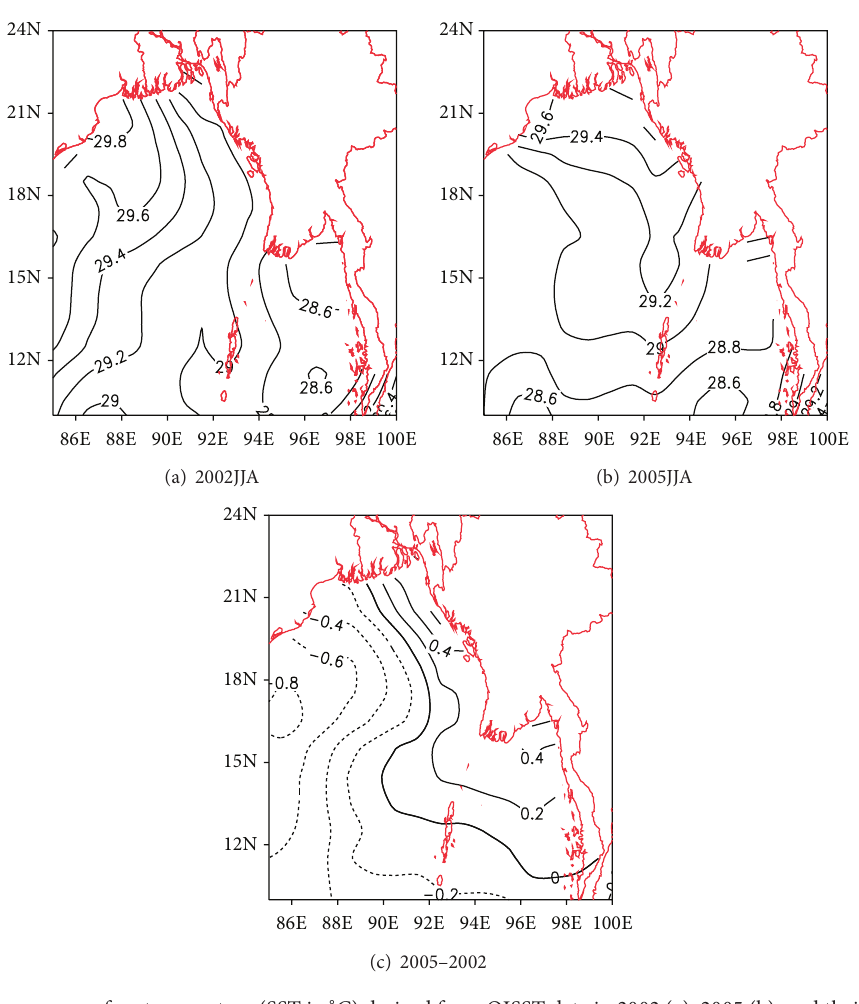
Figure 7: JJA mean sea surface temperature (SST in ∘ C) derived from OISST data in 2002 (a), 2005 (b), and their difference (c).